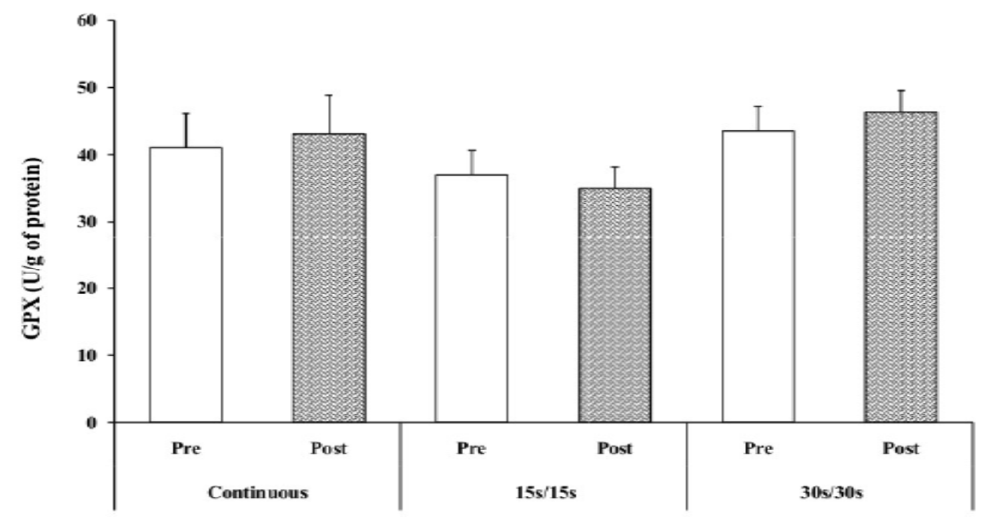
Figure 5. GPX activity at rest and immediately after